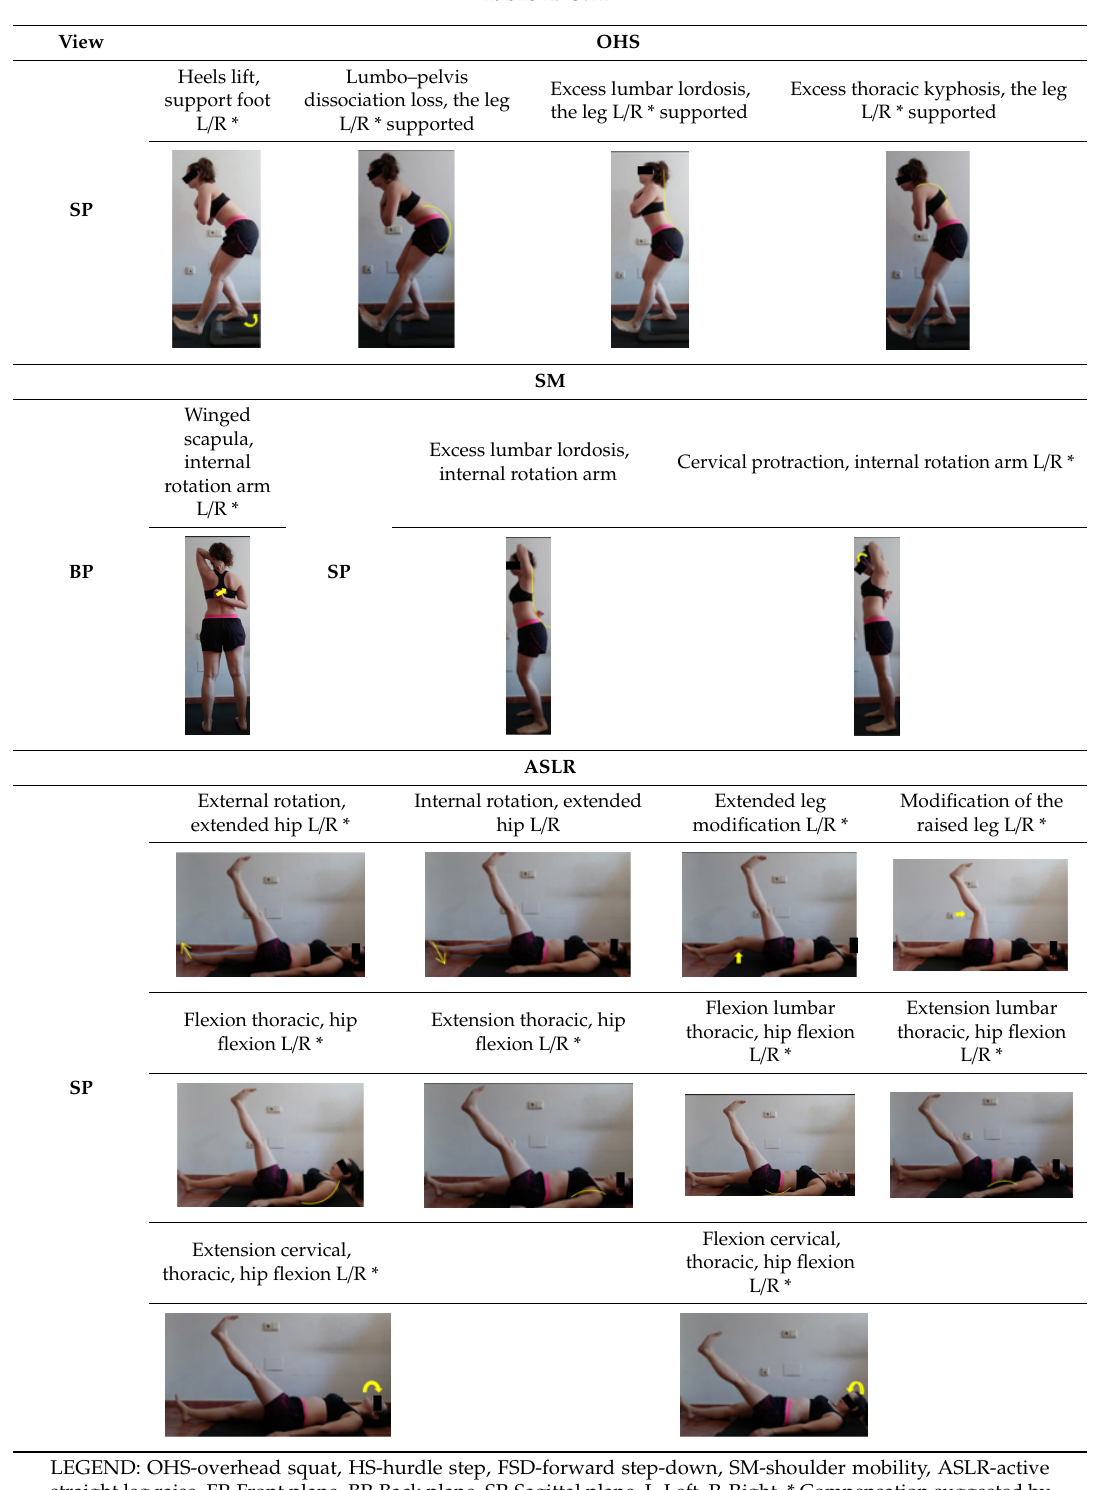
Table 3. Assessment of Aiken V by ten experts of the proposed variables for OHS .